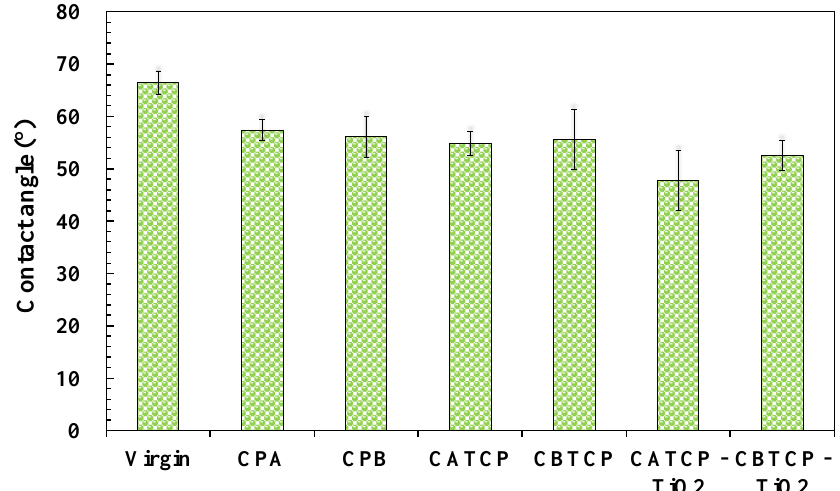
Figure 9. Contact angle measurements of the TFC and TFN membranes. The experimental conditions of TFN membranes are the same as those in Figures 6 and 7.